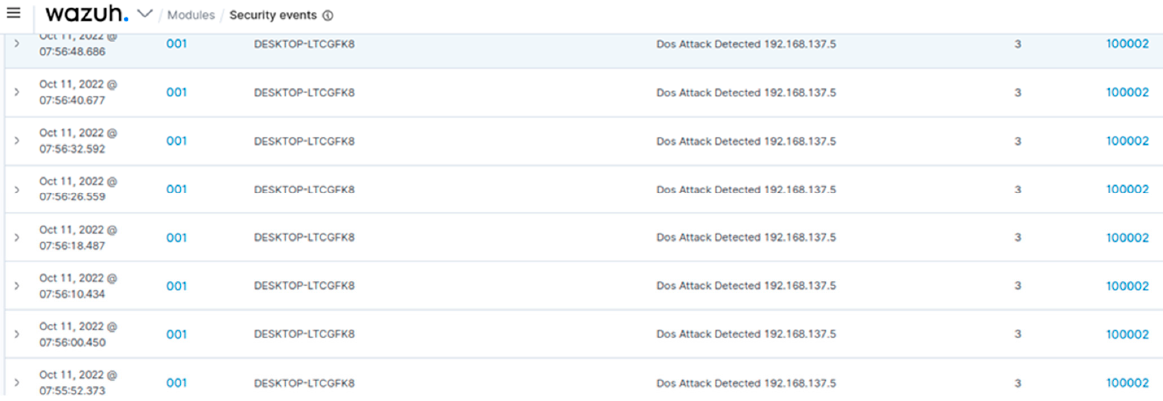
Figure 16. DoS A tt ack Alerts in Wazuh. Figure 16. DoS Attack Alerts in